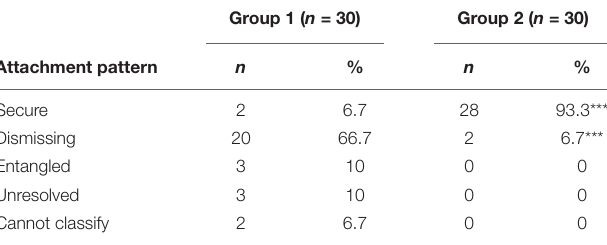
TABLE 1 | Distribution of AAI